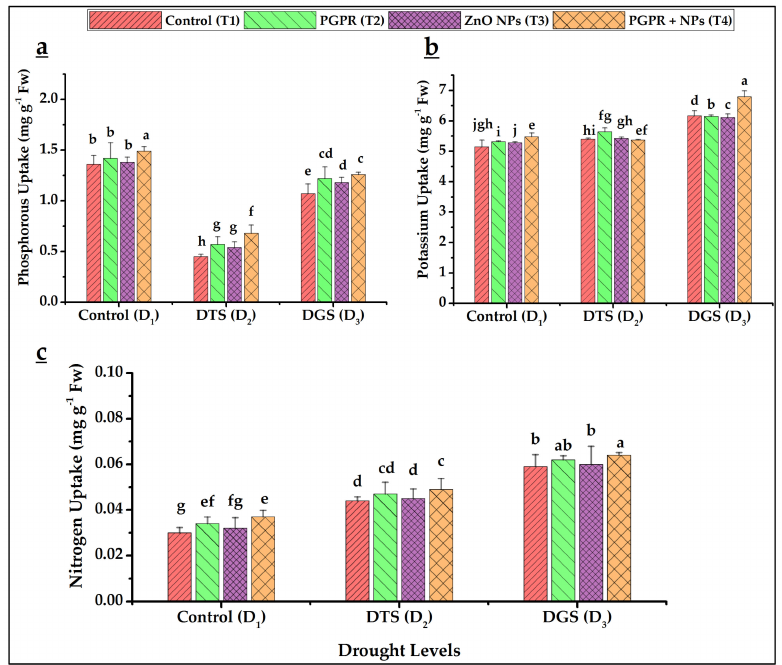
Figure 3. Phosphorus ( a ), potassium ( b ), and nitrogen ( c ) uptake in wheat as affected by Azospirillum brasilense and ZnO NPs under drought conditions. DTS = drought at tillering, DGS = drought at grain filling, T 1 = control, T 2 = single use of Azospirillum brasilense , T 3 = single use of ZnO NPs, and T 4 = co-application of PGPR and NPs. Error bars indicates standard error ( n = 3). (Note: Different lowercase letters indicate significant differences between different drought levels and treatments by the LSD test at p < 0.05).